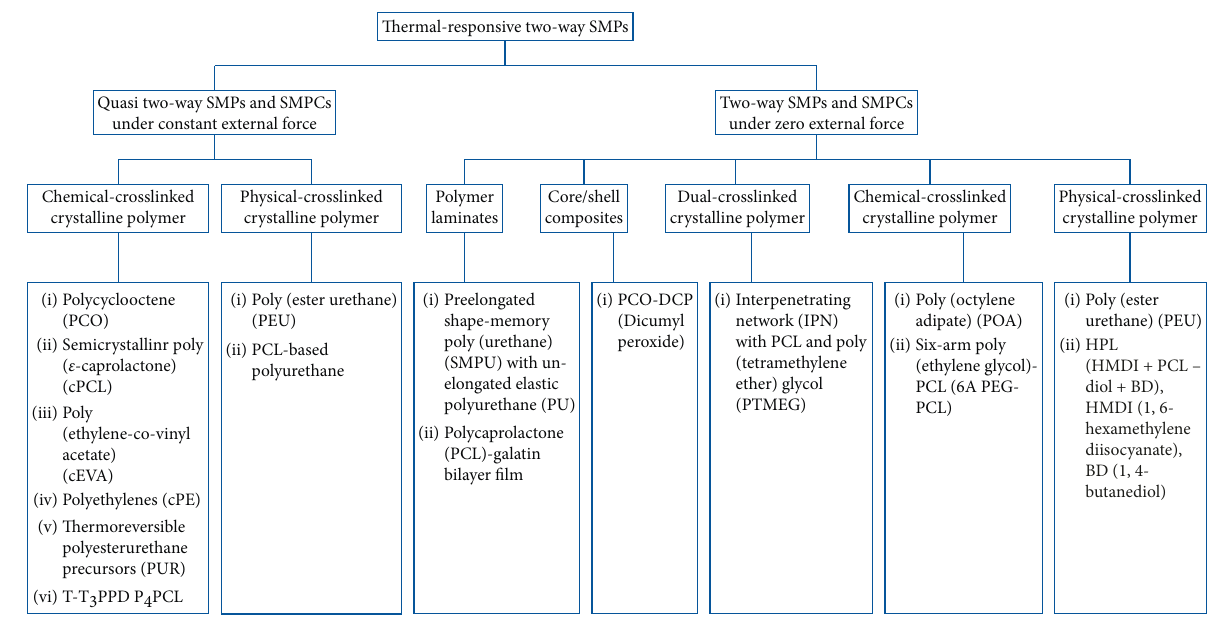
Figure 9: Thermally responsive two-way